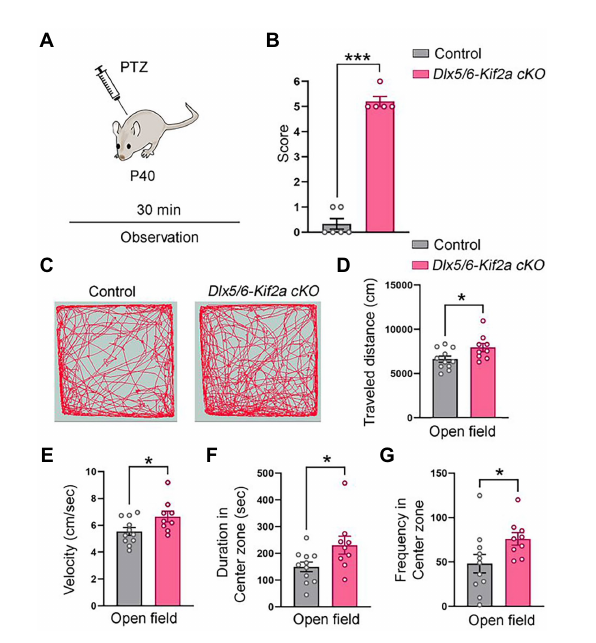
FIGURE 2 Dlx5/6-Kif2a cKO mice are hyperactive and more susceptible to epilepsy. (A) Experimental design of PTZ-induced seizure susceptibility experiments. (B) Graph showing mean score of seizure behavior for each genotype during the 30 min post-injection period (control mice n = 6, Dlx5/6-Kif2a cKO mice n = 5). (C) Illustrative example of mice movement in open field test. (D–G) Graphs showing the traveled distance (D) (control: 6630 ± 344 cm, n = 11; Dlx5/6-Kif2a cKO : 7951 ± 472 cm, n = 9), velocity (E) (control: 5.54 ± 0.29 cm/s, n = 11; Dlx5/6- Kif2a cKO : 6.65 ± 0.4 cm/s, n = 9), time in the center zone (F) (control: 149.7 ± 18 s, n = 11; Dlx5/6-Kif2a cKO : 230.5 ± 33.8 s, n = 9) and frequency in the open field center (G) (control: 48.04 ± 10.35, n = 11; Dlx5/6-Kif2a cKO : 76 ± 7.02, n = 9). Data are represented as mean ± SEM. Values were obtained by unpaired Student’s t-test; * p < 0.05, ** p < 0.01, and *** p < 0.001.